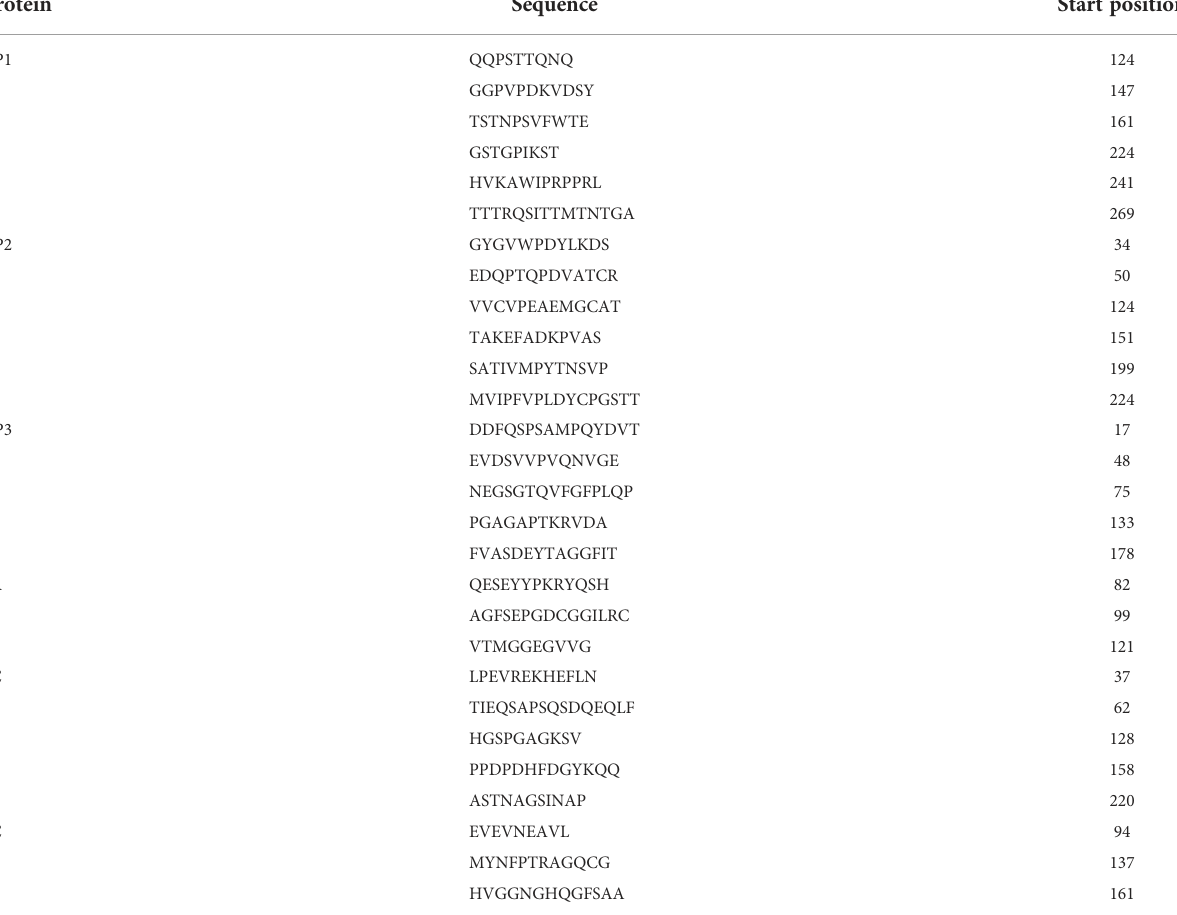
TABLE 4 Predicted line B-cell epitopes of CVB proteins utilized for the construction of a multi-epitope subunit vaccine.